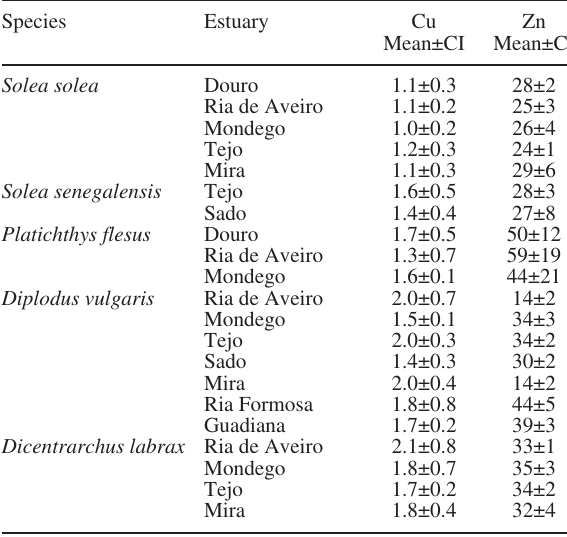
Table 3. – Mean concentrations of Cu and Zn (µg element g –1 muscle dry weight) (and 95% confidence intervals, CI) in muscle